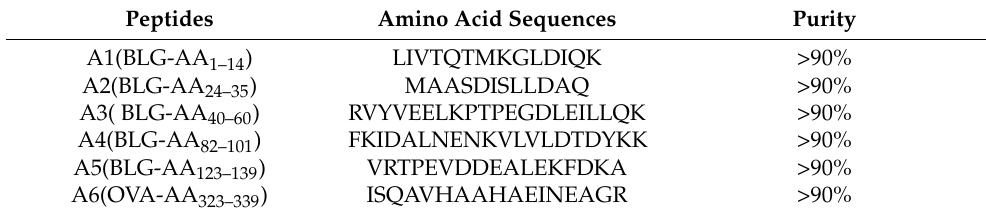
Table 3. The information of synthetic